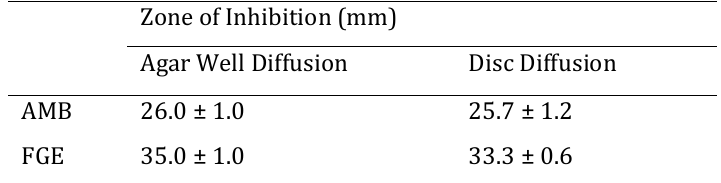
Table 2: Diameter of zones of inhibition noted